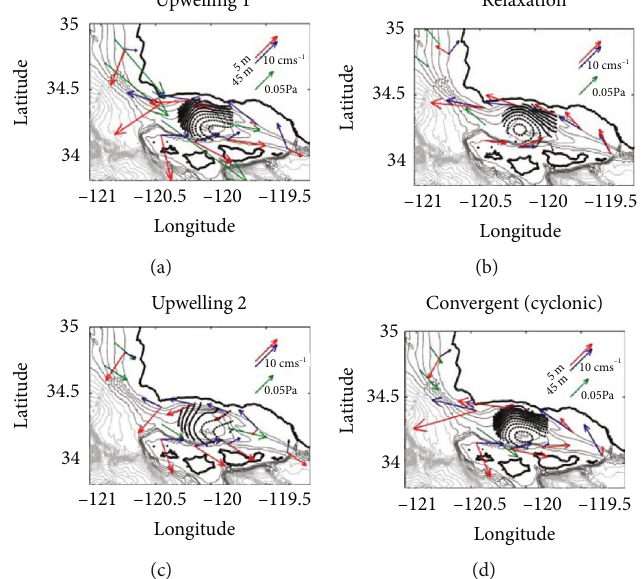
Figure 22: Mean wind stress patterns, currents, and CODAR fl ow patterns for (a) upwelling 1 and (b) relaxation, (c) upwelling 2, and (d) convergent fl ow patterns. See text for details. Current data from Oct. 1992 to Jan. 1996 also shown. Data key on fi gure. After Beckenbach